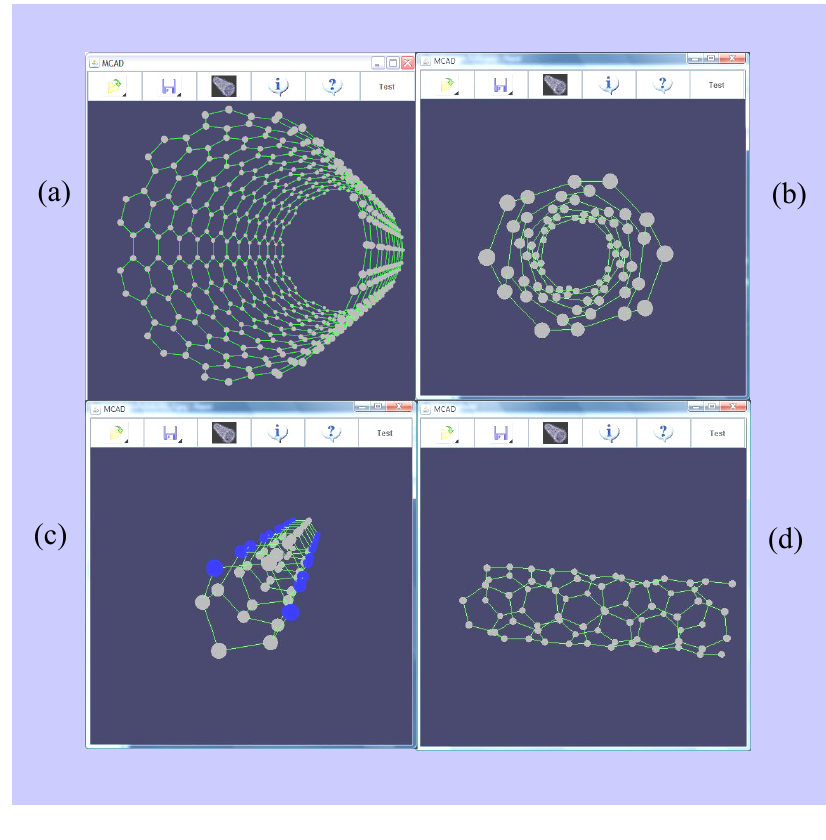
Figure 9. Examples of different NT configurations generated by MCAD such as (a) armchair, (b, d) chiral, and (c) zigzag nanotubes doped with